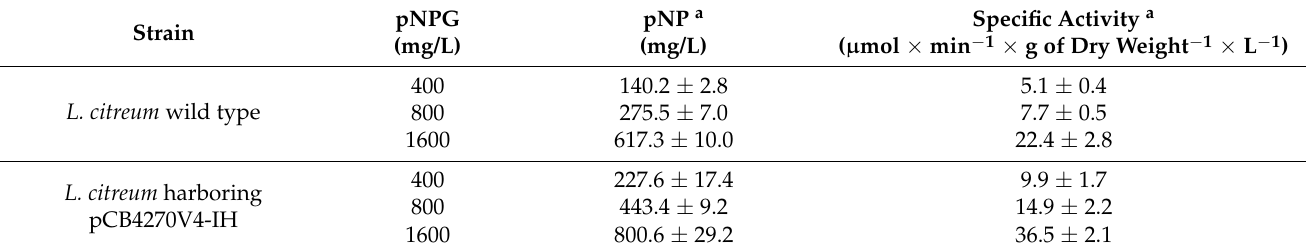
Table 1. Summary of in vivo β -glucosidase activity in L. citreum harboring pCB4270V4-IH.